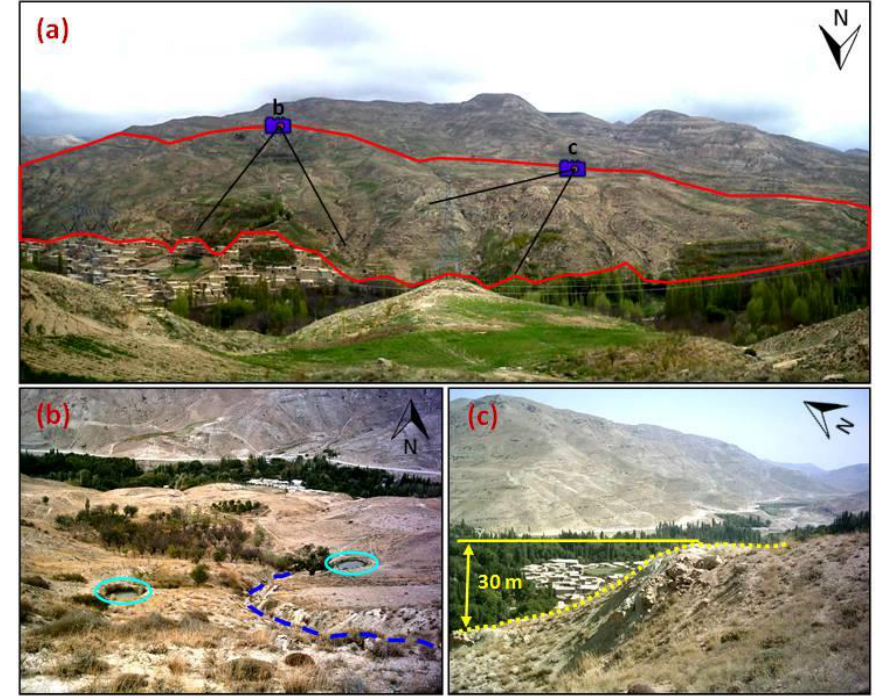
Figure 3. ( a ) A panorama photo from the north toward the study slope, which is approximately indicated by the red line; ( b ) a close-up view from the south and upper part toward the north and down the slope. Cluttered topography is obviously depicted in the photo. Additionally, two natural springs and a deep track, which was created by water erosion, are shown on this slope; ( c ) a close-up view from the west to a scarp on the slope, which is formed as a result of former activity from the